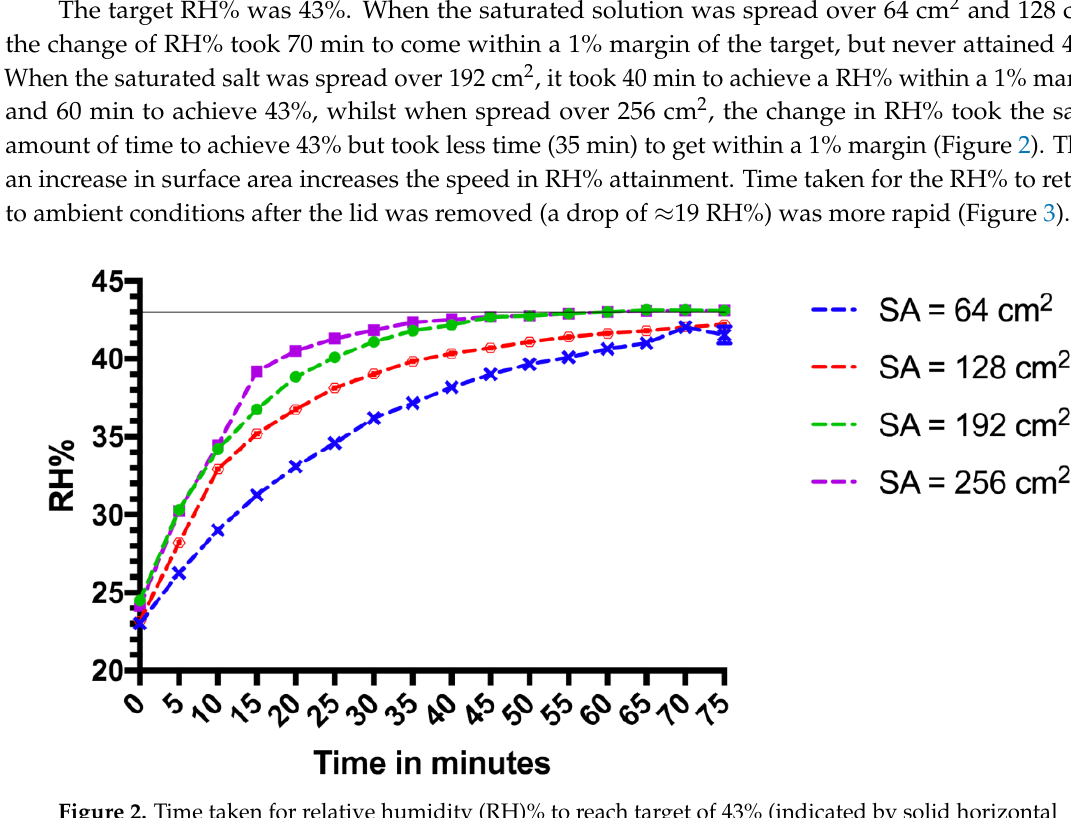
Figure 2. Time taken for relative humidity (RH)% to reach target of 43% (indicated by solid horizontal line). Each surface area contained 75 g of K 2 CO 3 mixed with 50 g of water (to create a slurry) which was evenly spread over either 64 cm 2 , 128 cm 2 , 192 cm 2 or 256 cm 2 . Data points were taken every five minutes. Each surface area was tested three times. SA = surface area of saturated salts.